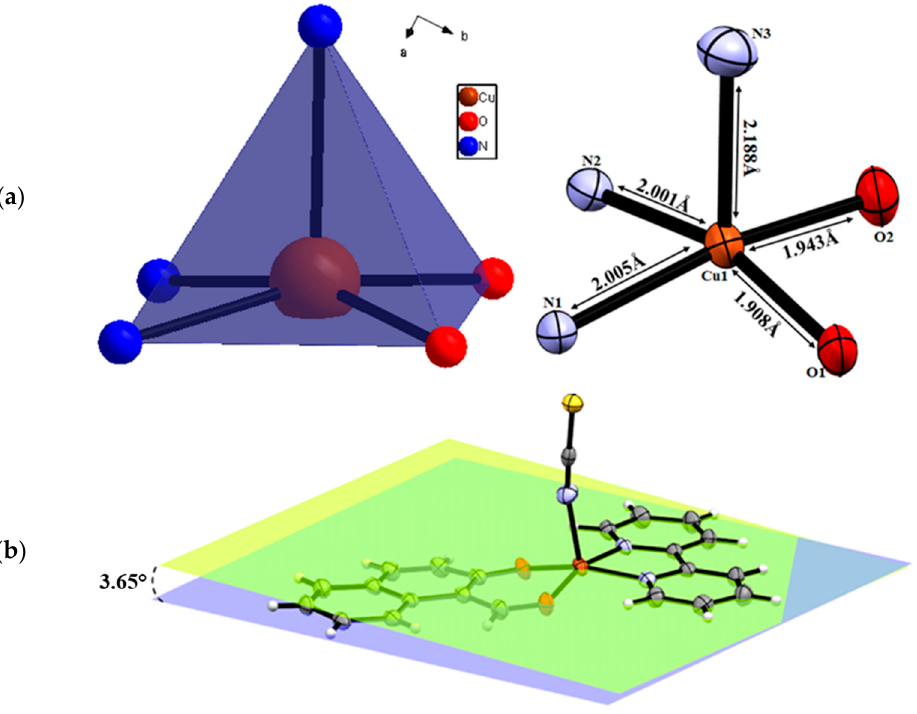
Figure 2. The copper square-pyramidal environment ( a ), and the dihedral angle between the two ligands ( b ).